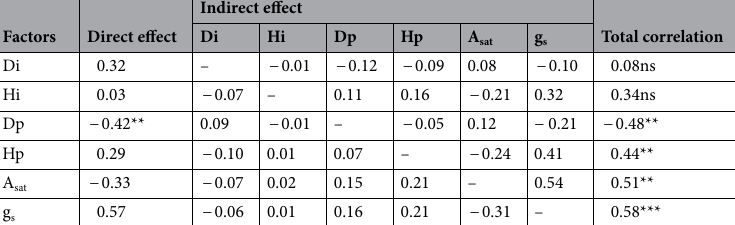
Table 4. Path analysis of the relationships between outplanting survival and the various independent variables (growth and leaf-level physiology). Di diameter at planting, Hi height at planting, Dp diameter after outplanting, Hp height after outplanting, A sat photosynthesis after outplanting, g s stomatal conductance after outplanting. ** and *** the correlation is significant at the p < 0.05 and p < 0.01 level.